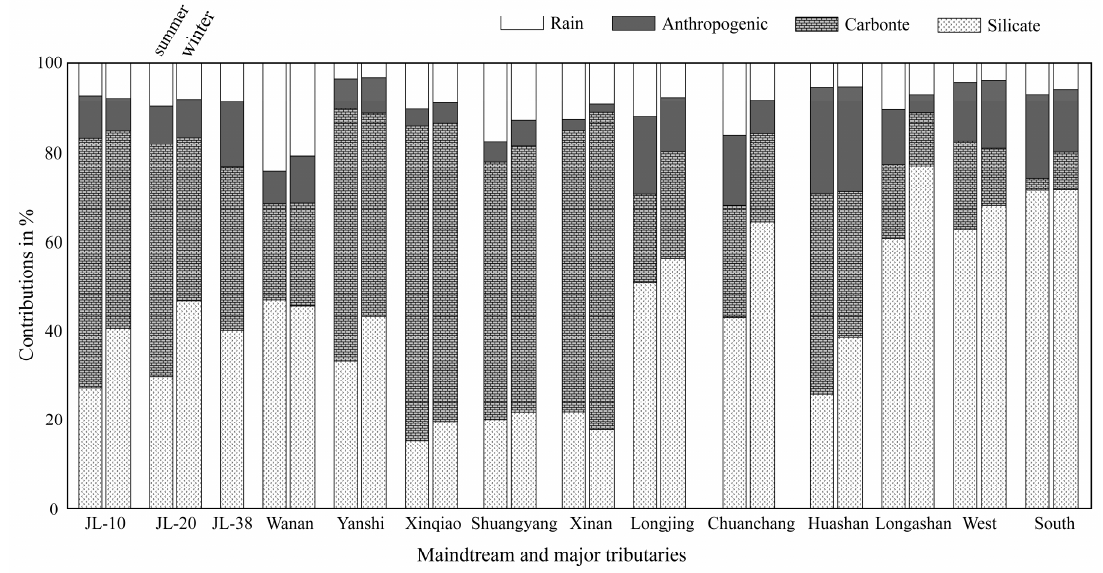
Figure 6. The contributions of different reservoirs (rain, anthropogenic inputs, silicate and carbonate weathering inputs) to the total cations (in mg/L). JL-10, JL-20 and JL-38 represent the upper, middle and lower reaches of mainstream, respectively.